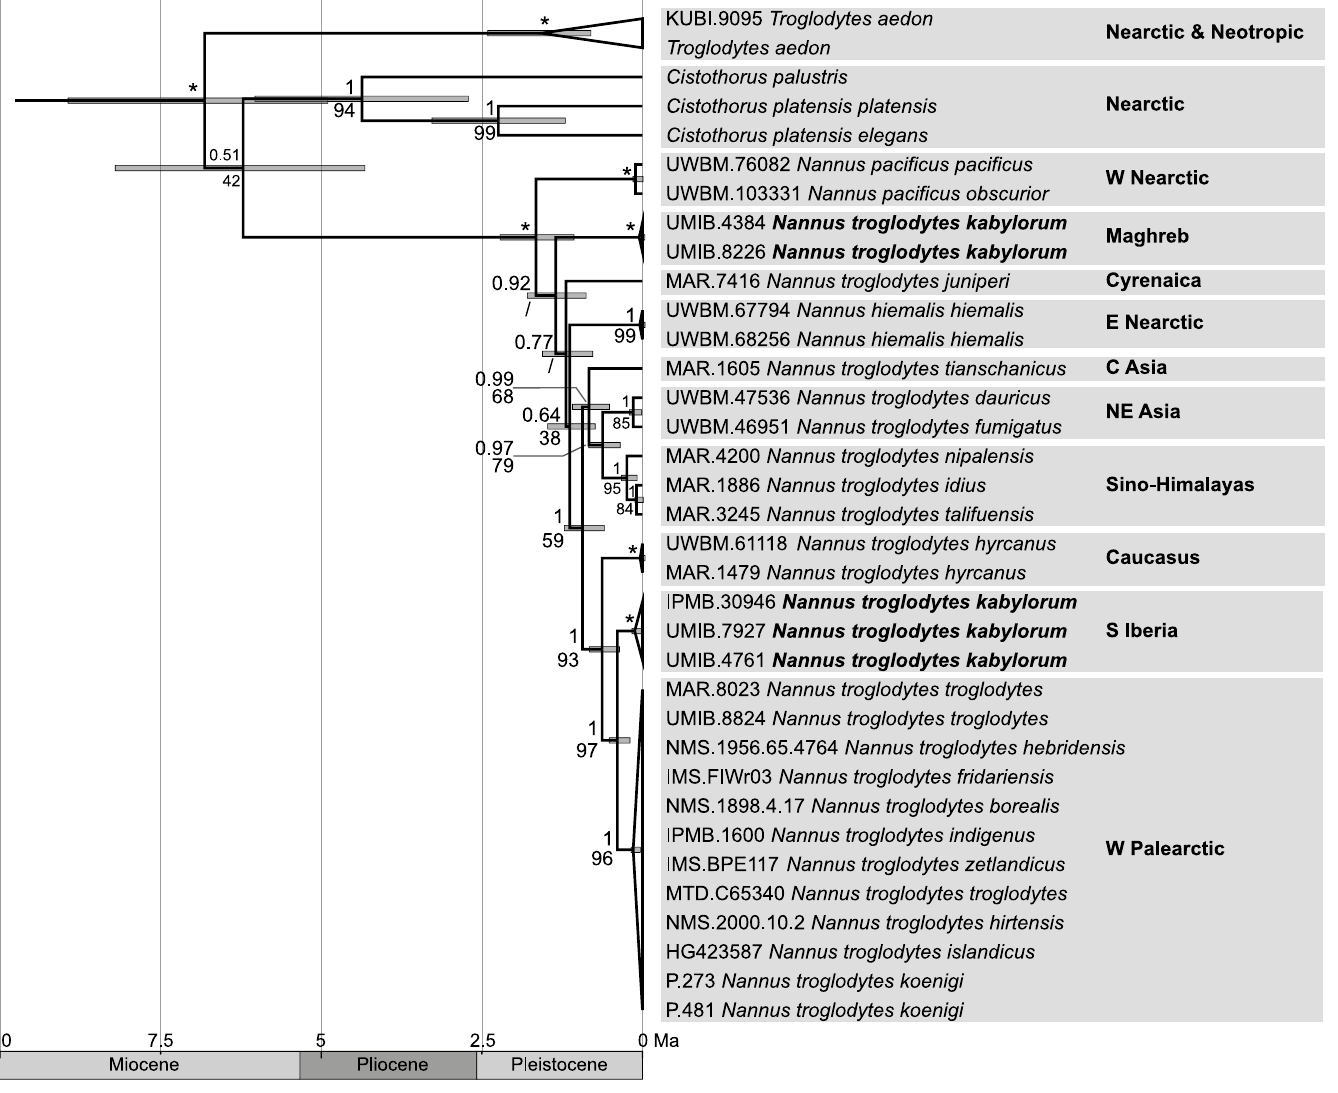
Fig 5. Multi-locus phylogeny of the Nannus pacificus/hiemalis/troglodytes species complex with outgroups reduced to troglodytes aedon and Cistothorus spp. (n = 35). Bayesian reconstruction across the five loci COI (696 bp), ND2 (1033 bp), Myo2 (736 bp), Fib5 (570 bp), and RAG1 (763 bp). Node support values indicate Bayesian posterior probabilities (above nodes) and bootstrap values of maximum likelihood analysis (below nodes; / = node was not recovered in the ML tree); asterisks mark nodes with full support from both analyses. Divergence times estimated with fossil calibration; 95% confidence intervals shown as node bars. Holocene (0.012–0 Ma, [81]) omitted on timescale for